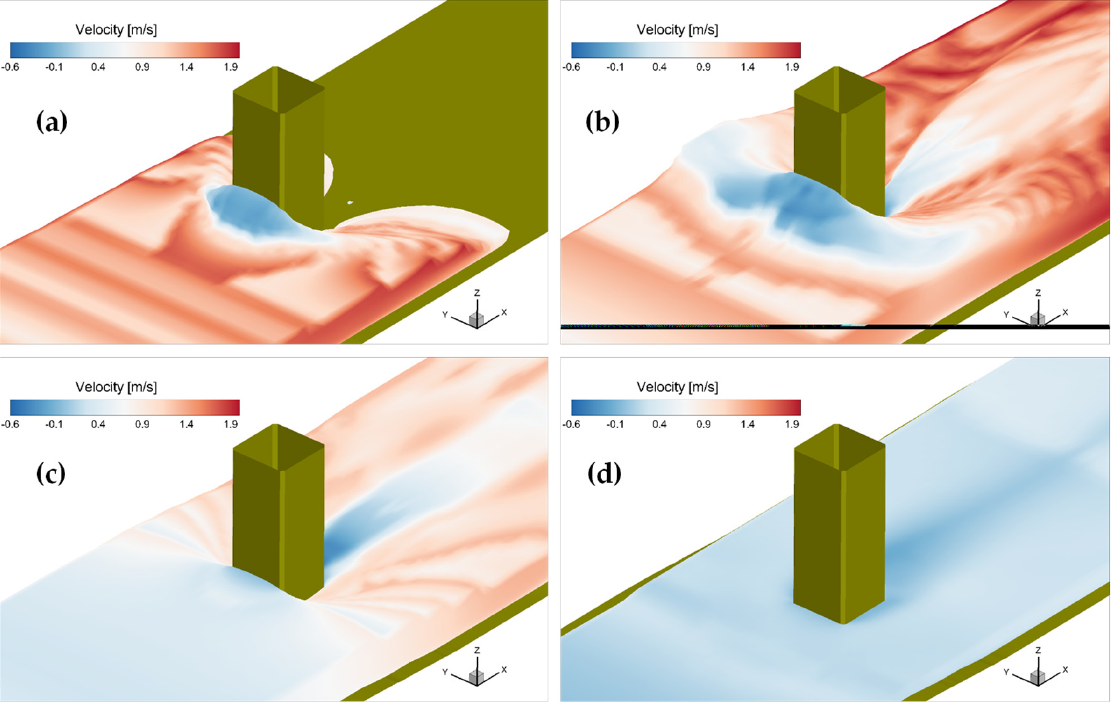
Figure 7. Simulated free surface flow features around structure at the moments of ( a ) t 1 , ( b ) t 2 , ( c ) t 3 , and ( d ) t 4 .